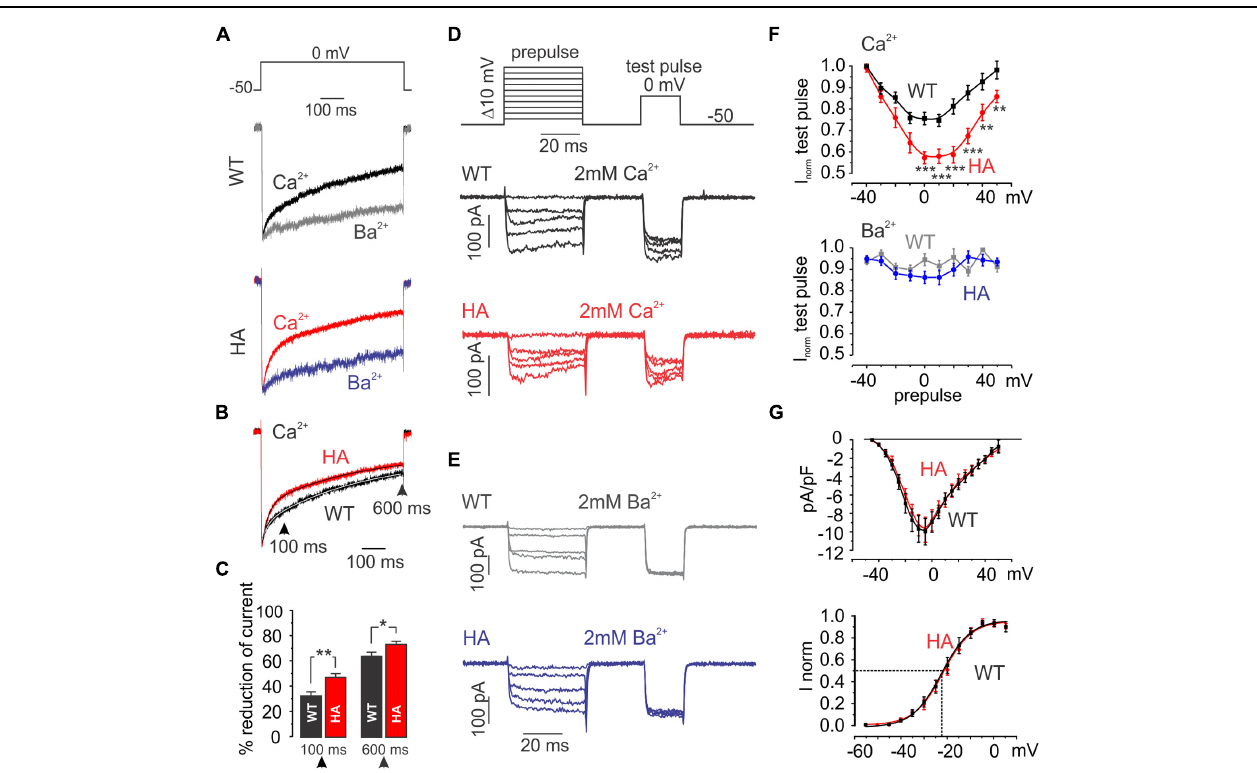
FIGURE 9 | L-type currents in MCCs from WT and Cav1.3DCRD HA / HA mice. (A) Averaged L-type currents of WT ( n = 23) and Cav1.3DCRD HA / HA (HA, n = 27) MCCs measured in 2 mM Ca 2 + (black and red) or 2 mM Ba 2 + (gray and blue) triggered by the protocol shown on top. L-type currents were obtained by subtraction of nifedipine (3 μ M) resistant current from control traces and normalized to the peak. (B) Superimposed L-type currents obtained in 2 mM Ca 2 + from WT and Cav1.3DCRD HA / HA MCCs. Double exponential fits of the averaged traces (continuous curves within traces) revealed the following parameters: A fast = − 0.14, A slow = − 0.57, τ fast = 23.8 ms, τ slow = 397.7 ms and C = − 0.25 for WT and A fast = − 0.34, A slow = − 0.46, τ fast = 24.9 ms, τ slow = 382.9 ms and C = − 0.20 for DCRD HA / HA MCC L-type currents.